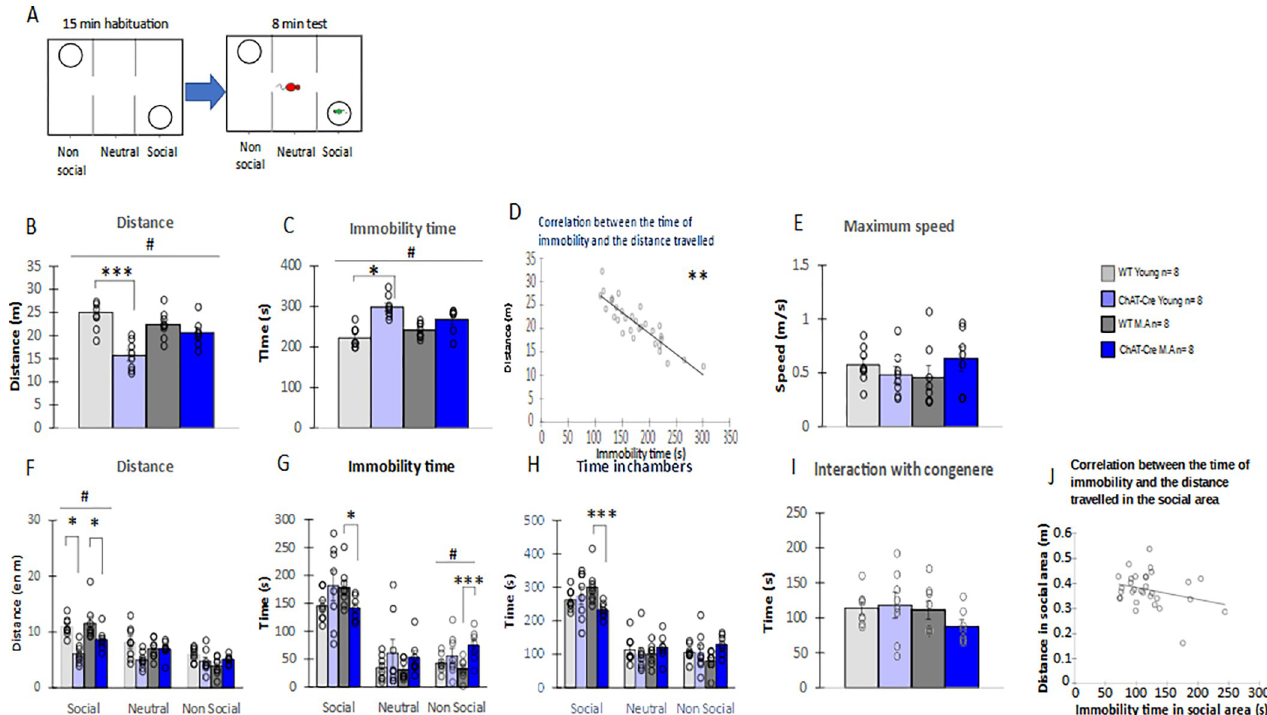
Fig 5. Behavior in the 3-chamber task. A) Procedure. Host mice used for this experiment were WT Young n = 8; ChAT-Cre Young n = 8; WT Middle Age (M.A) n = 8; ChAT-Cre Middle Age (M.A) n = 7. The visitor mice used were all WTs of same age and sex than host mice (young n = 6, M.A. n = 6) maintained in social cages. B) Distance travelled. C) Immobility time. D) Correlation between the time of immobility and the distance travelled. E) Maximum speed. F) Distance travelled in chambers. G) Immobility time in chambers. H) Time spent in chambers I) Time of interaction with the congener. J) Correlation between the time of immobility and the distance travelled in the social area. Data are presented as means ± SE; � p < 0.05; �� p < 0.01; ��� p < 0.001; Kruskal-Wallis rank- sum test analysis then Wilcoxon and d signed-rank tests were applied when appropriate. # represents the genotype effect and υ the age effect. Kruskal-Wallis results were not represented for